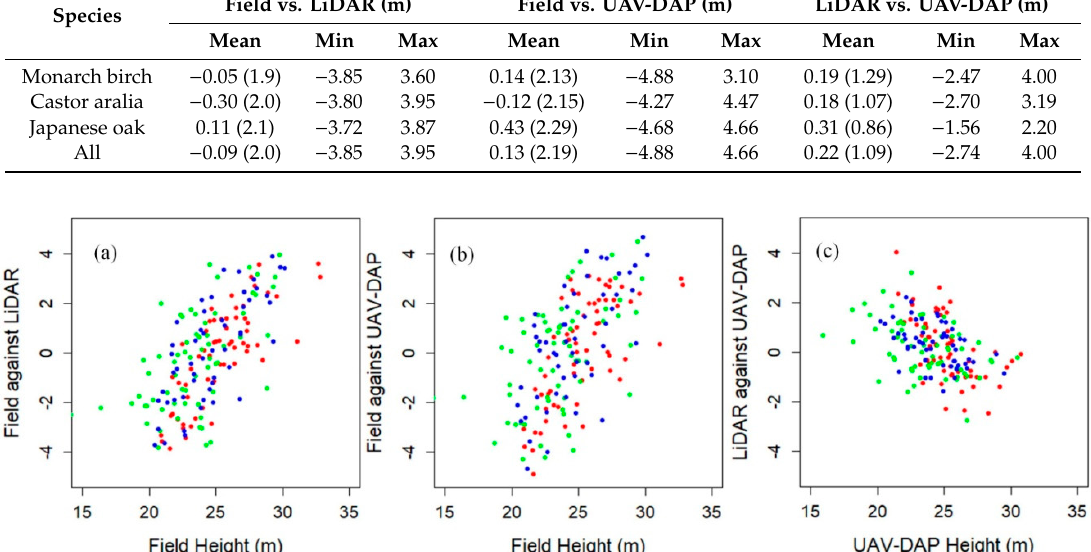
Table 5. Height differences between field measured and RS tree height (standard deviation in parenthesis).